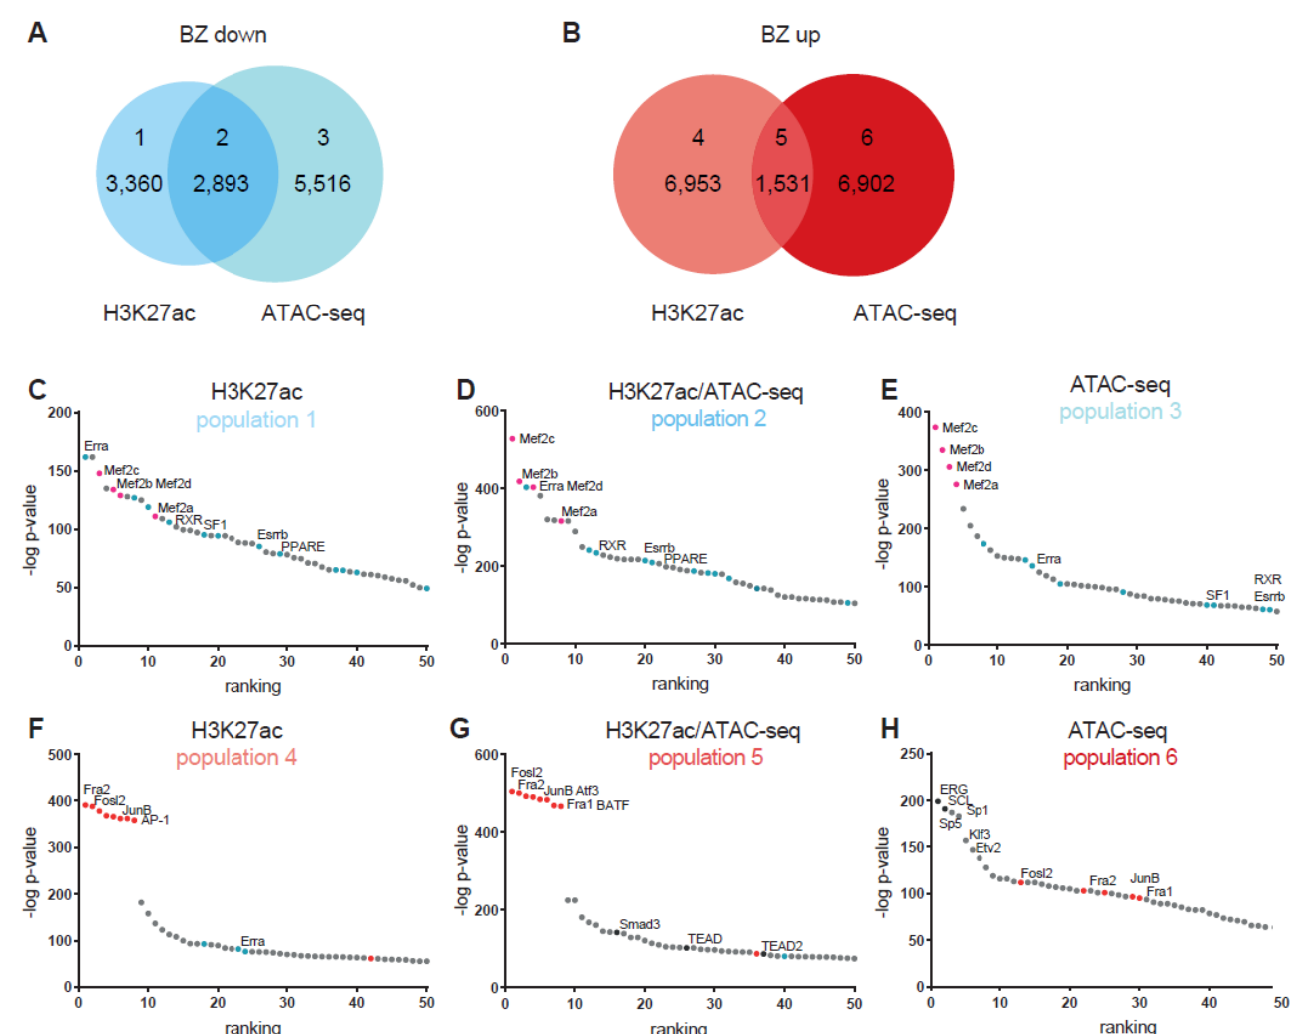
Figure 3. Venn diagram showing overlapping decrease ( A ) and increase ( B ) in H3K27ac and chromatin accessibility by ATAC-seq. Enriched motifs recognized by transcription factors for loci with decreased H3K27ac ( C ), decreased H3K27ac and chromatin accessibility ( D ), or decreased chromatin accessibility only ( E ) . Enriched motifs recognized by transcription factors for loci with increased H3K27ac ( F ), increased H3K27ac and chromatin accessibility ( G ), or increased chromatin accessibility only ( H ).